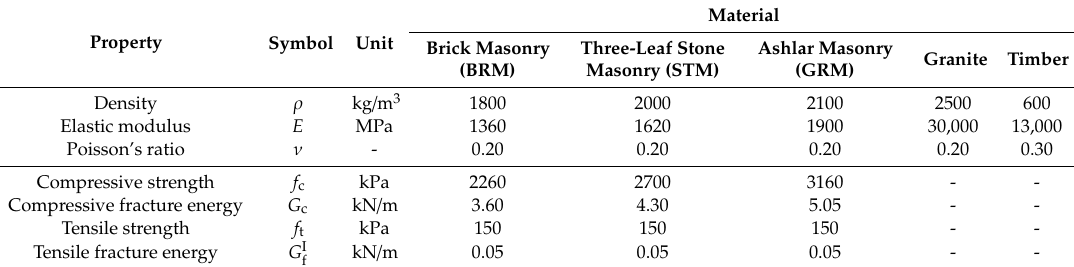
Table 1. Linear-elastic and nonlinear properties of